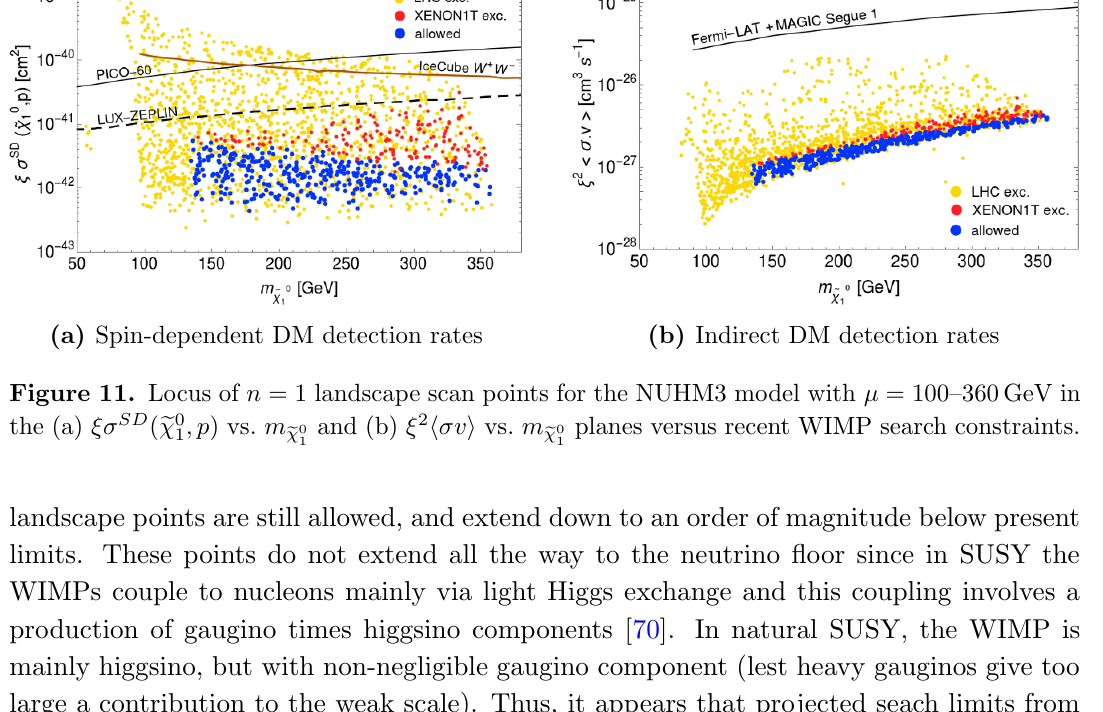
Figure 10. Locus of n = 1 landscape scan points for the NUHM3 model in the (cid:24)(cid:27) SI ( m plane versus recent WIMP search constraints for (cid:22) = 100{360 GeV. Red points are excluded e (cid:31) 0 1 by XENON1T search limits but not by LHC Run 2 constraints. Projected reaches from several future SI DD experimentes are also shown.